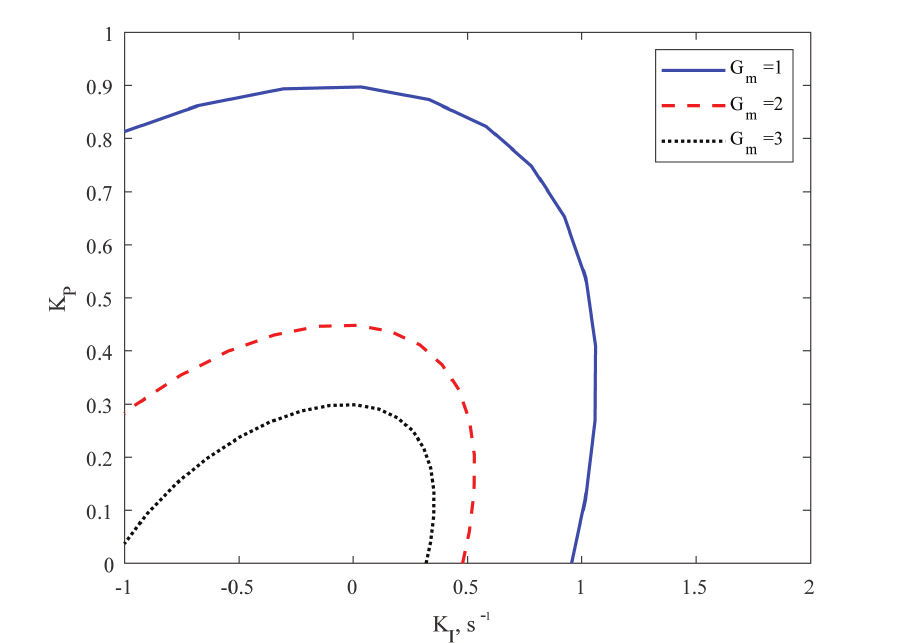
Figure 10. The stability region for single-area LFC system with G m = 1, G m = 2, and G m = 3